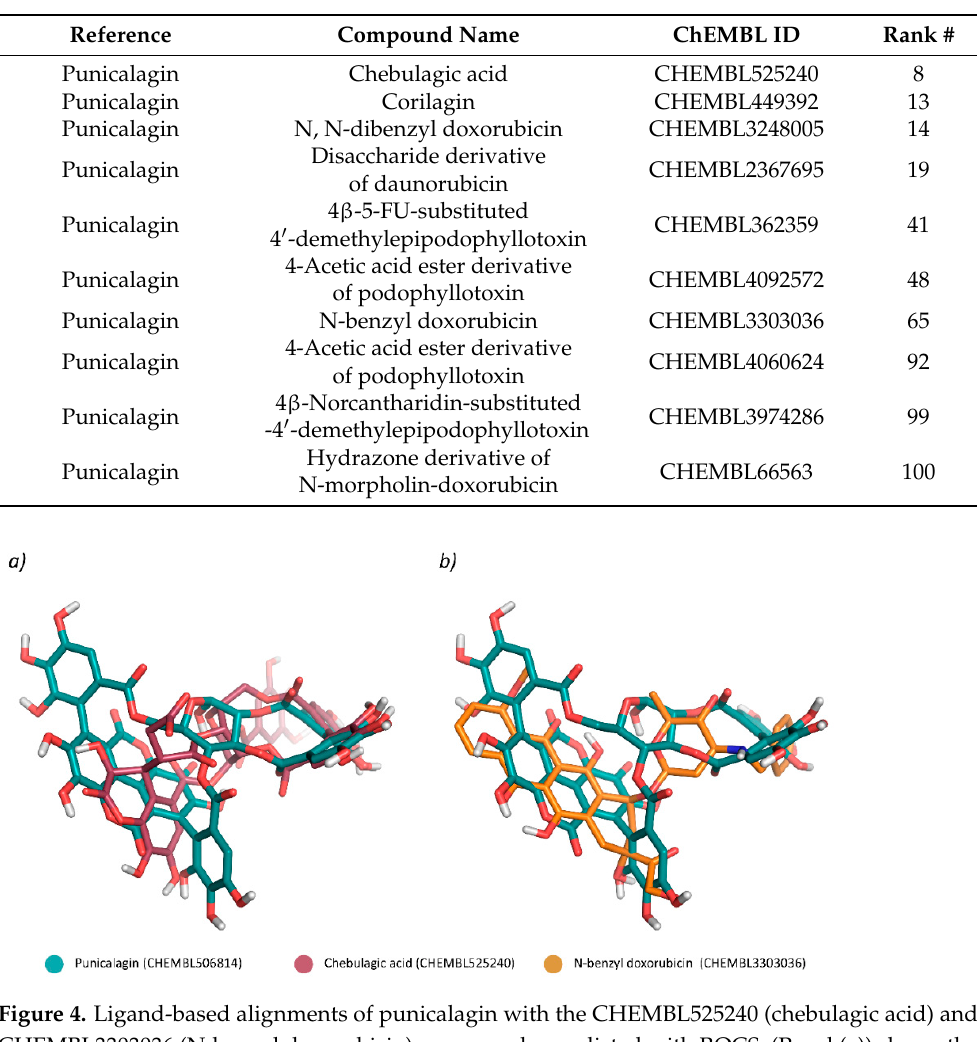
Table 3. ChEMBL ligands related to DNA topoisomerases I and II identified within the first 100 top- ranking alignments of the ChEMBL/Punicalagin 3D ligand-based similarity comparisons.